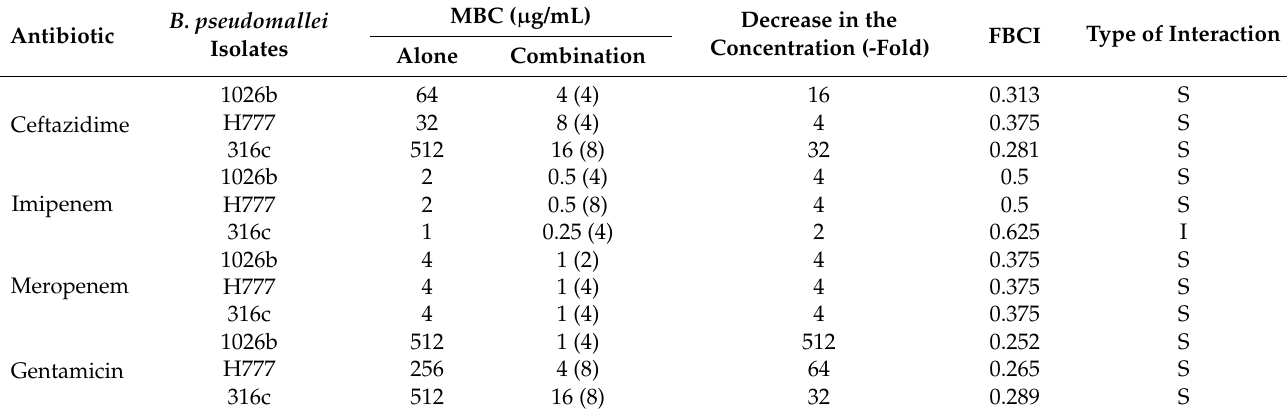
Table 3. Minimum bactericidal concentrations (MBCs; µ g/mL) of the antibiotics alone or in combination with AgNPs. Fold change in the MBC of the antibiotics in combination or